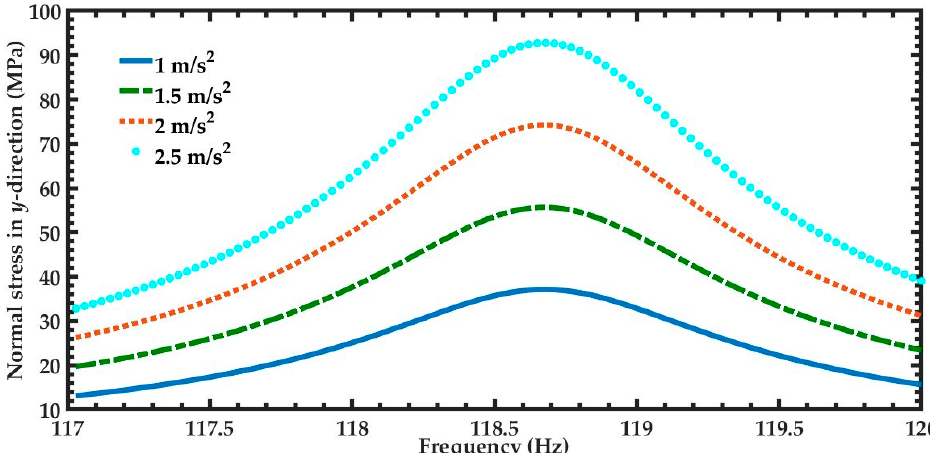
Figure 14. Maximum normal stress in x -direction of the nanogenerator regarding four different accelerations in y -direction and a frequency range from 117 to 120 Hz.